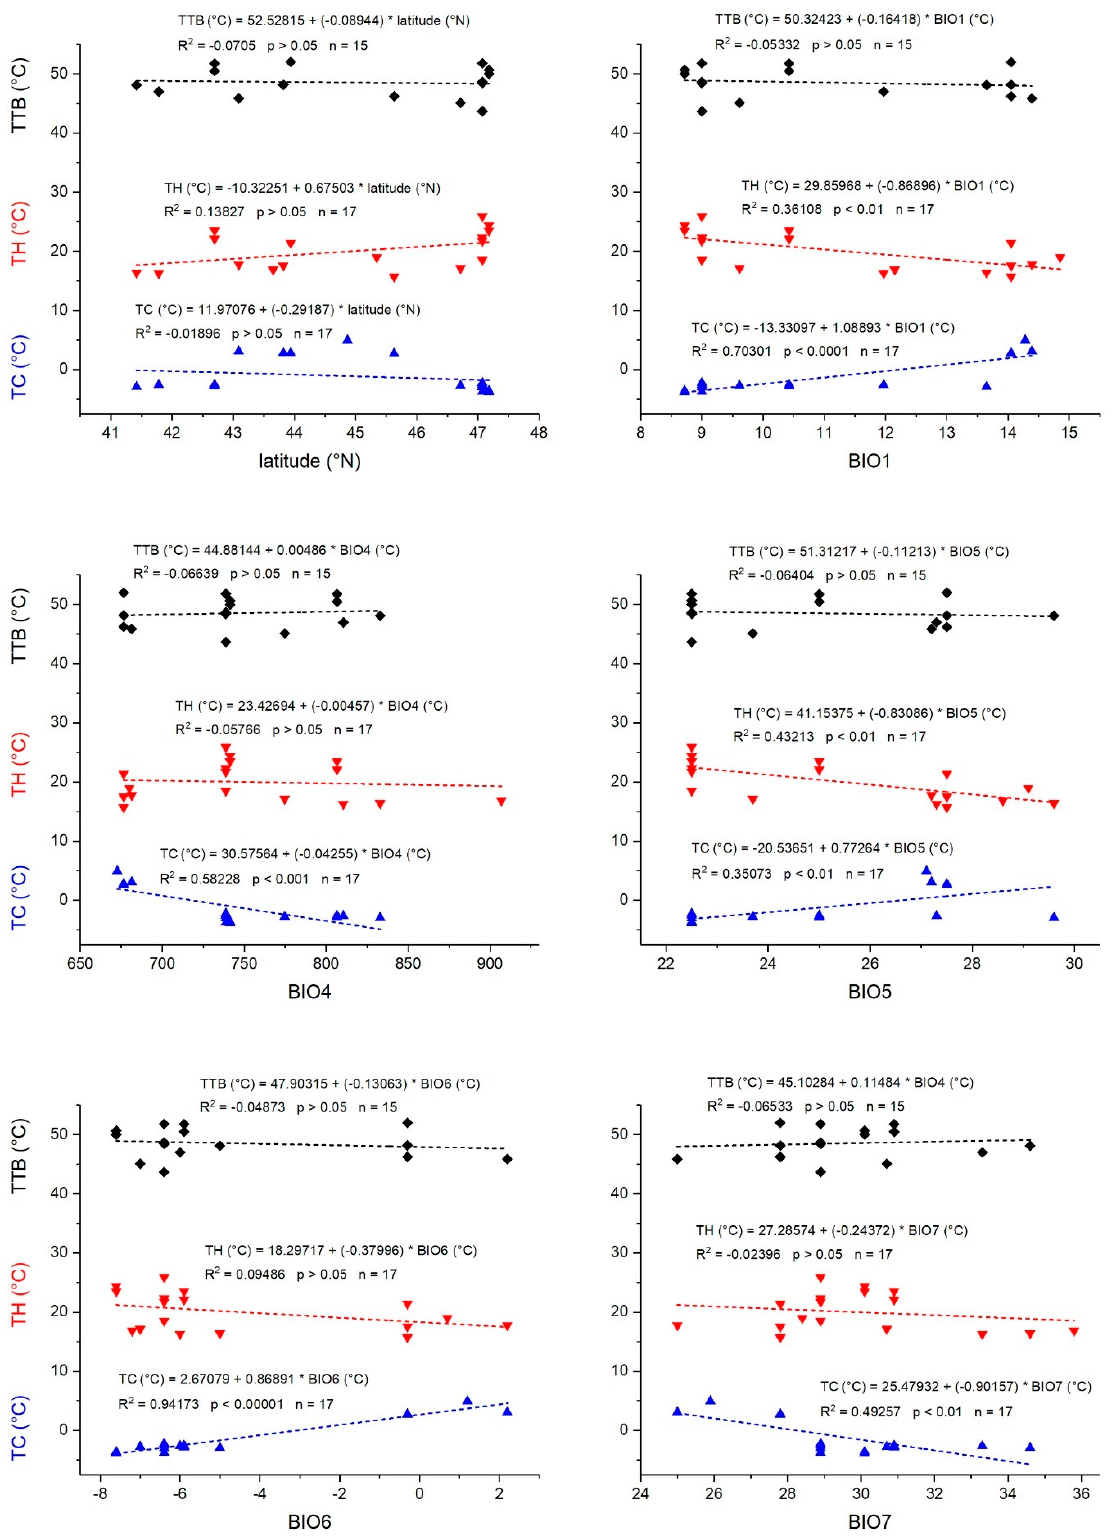
Figure 3. Physiological parameters thermal tolerance breadth (TTB, black), and heat and cold tolerance (TH, red; TC, blue) derived from CT max and CT min (see Methods section) in dependence on latitude and bioclimatic variables (BIO1, BIO4–BIO7). Dots represent means of individual species at certain sample sites. See also Table 2 and Table S2.